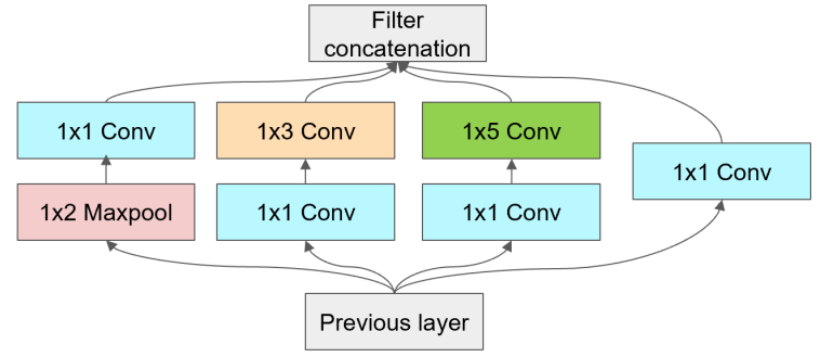
Figure 3. Convolutional neural network of layer 1.